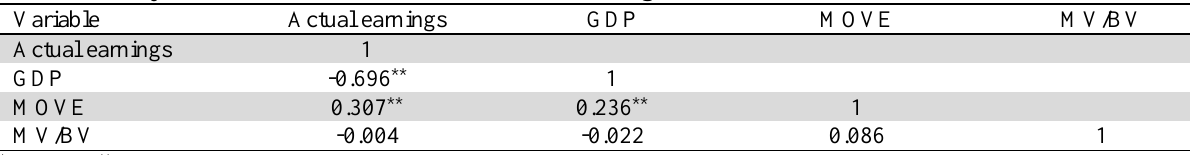
The summary of correlation test for forecasted earnings Variable